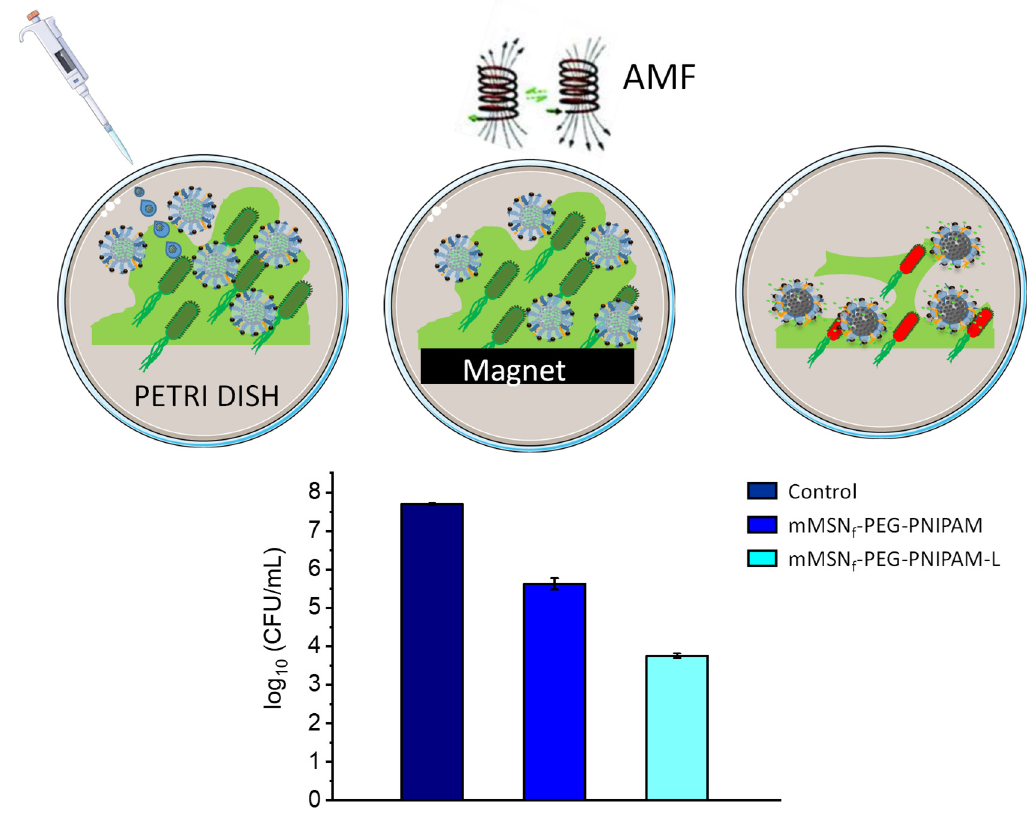
Figure 6. Bactericidal effect of mMSN f -PEG-PNIPAM-L nanosystem on E. coli biofilm. The graph shows log 10 (CFUs per mL) after biofilm exposure to 200 µ g/mL of the nanosystems for 16 h, compared with biofilm without nanoparticles as control (first bar). Data are mean ± SD of three independent experiments.